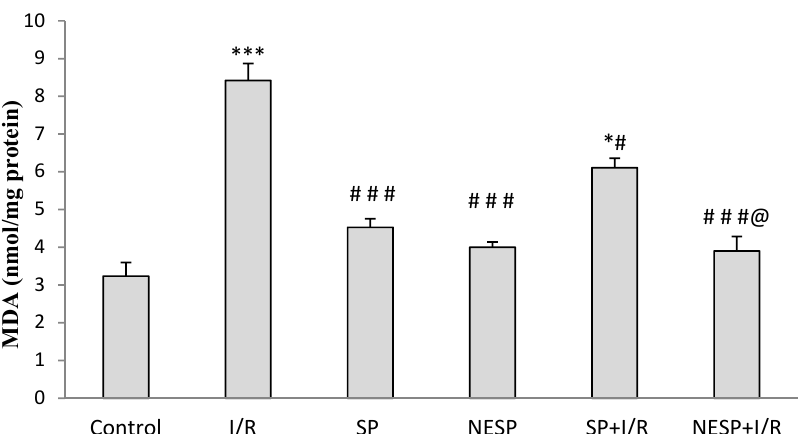
Figure 2. Levels of renal malondialdehyde (MDA), an index of lipid peroxidation, in different animal groups ( n = 8) at the end of interventions: Control, ischemic/reperfusion (I/R), spironolactone (SP), nano-encapsulated spironolactone (NESP), spironolactone-treated I/R (SP + I/R) and NESP-treated I/R (NESP + I/R) groups. * p < 0.05 and *** p < 0.001 (compared to control group). # p < 0.05 and ### p < 0.001 (compared to I/R group). @ p < 0.05 (difference between SP-treated I/R group and